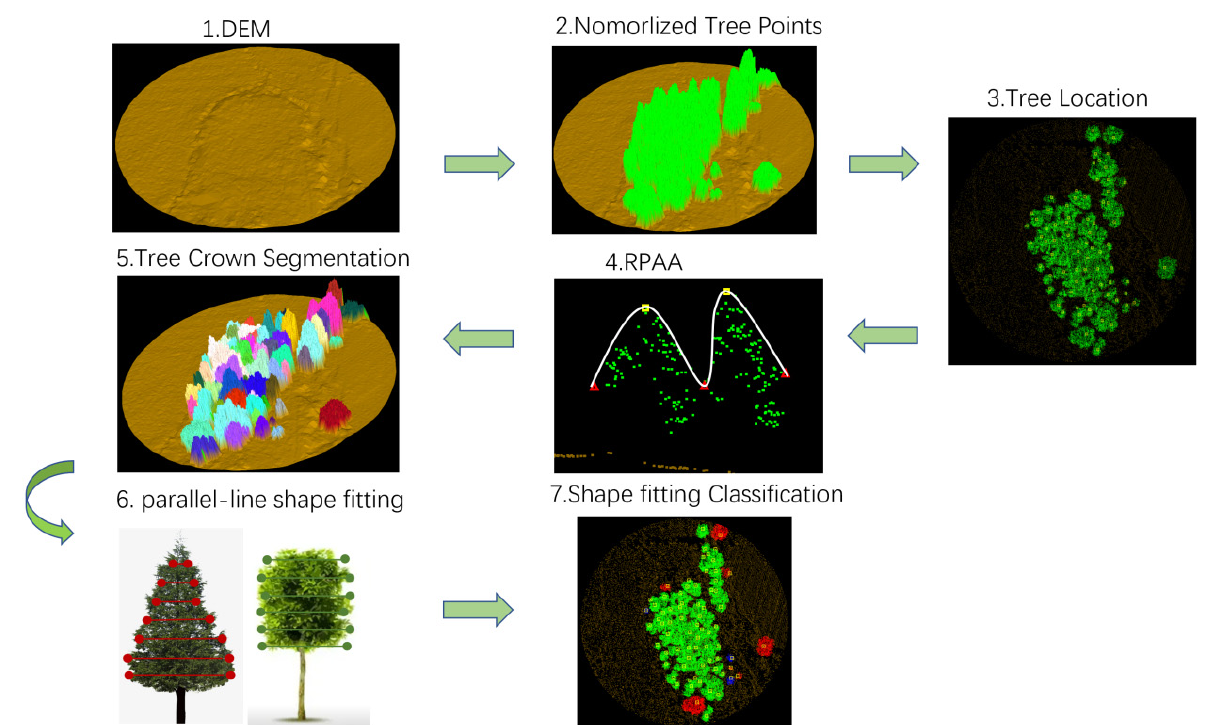
Figure 2. Procedure of trees species classification: First, a DEM is generated; second, the normalized tree points are generated; third, rough tree location generation; fourth, a rotating profile analysis algorithm refines the tree locations; fifth, segmentation of the tree crowns; sixth, calculation of the key points from the segmented crowns points; seventh, tree species classification using shape fitting method.